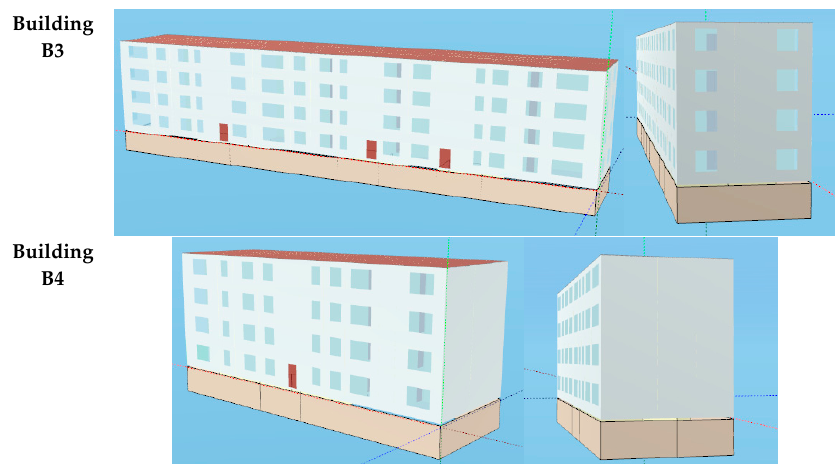
Figure 2. Buildings model visualization.